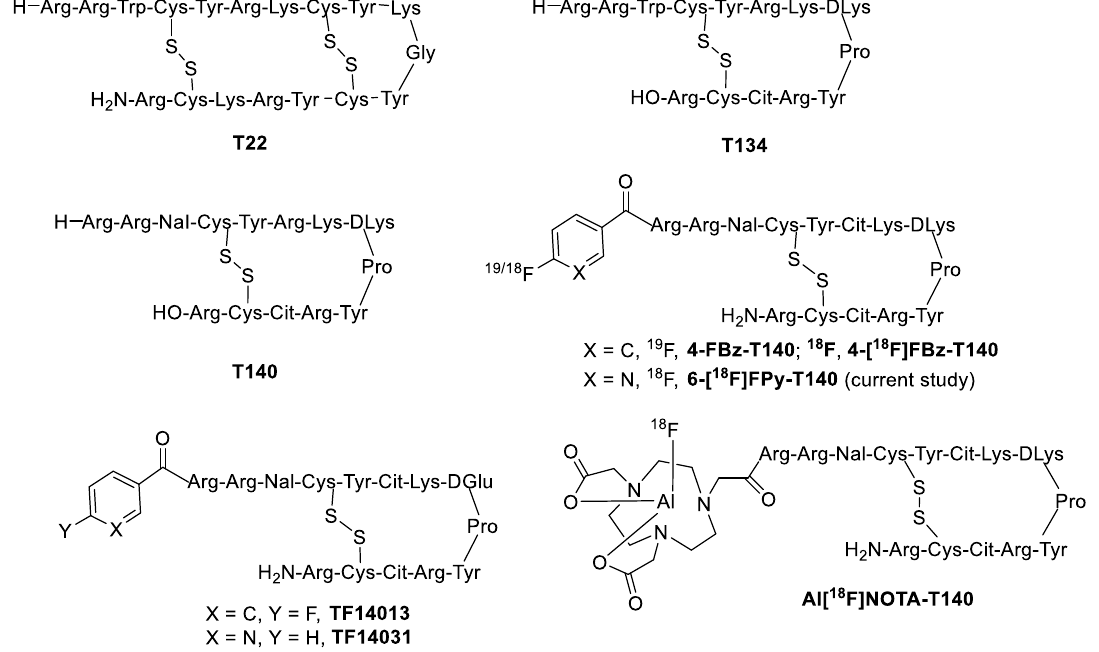
Figure 1. Structures of C-X-C motif chemokine receptor 4 (CXCR4) ligands.